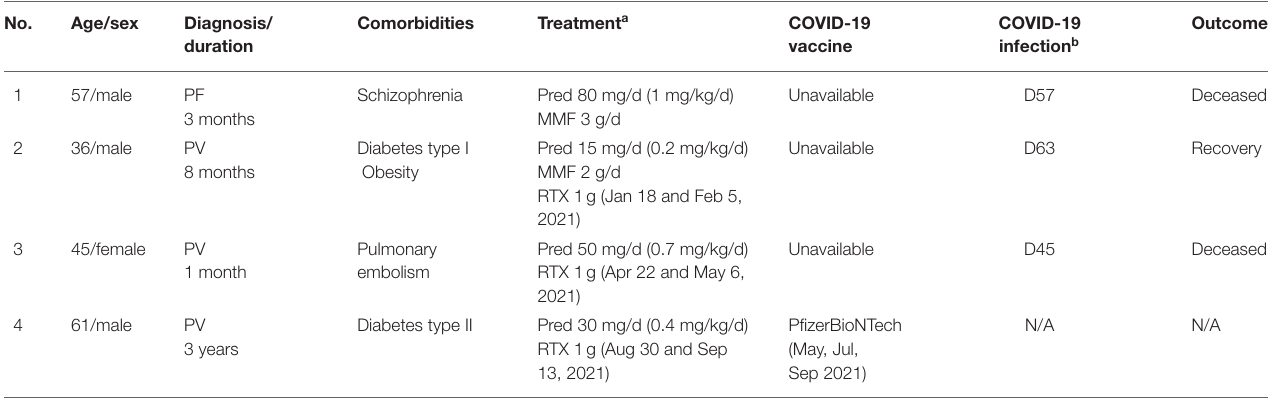
TABLE 1 | Summary of AIBD cases treated during COVID-19 pandemic.